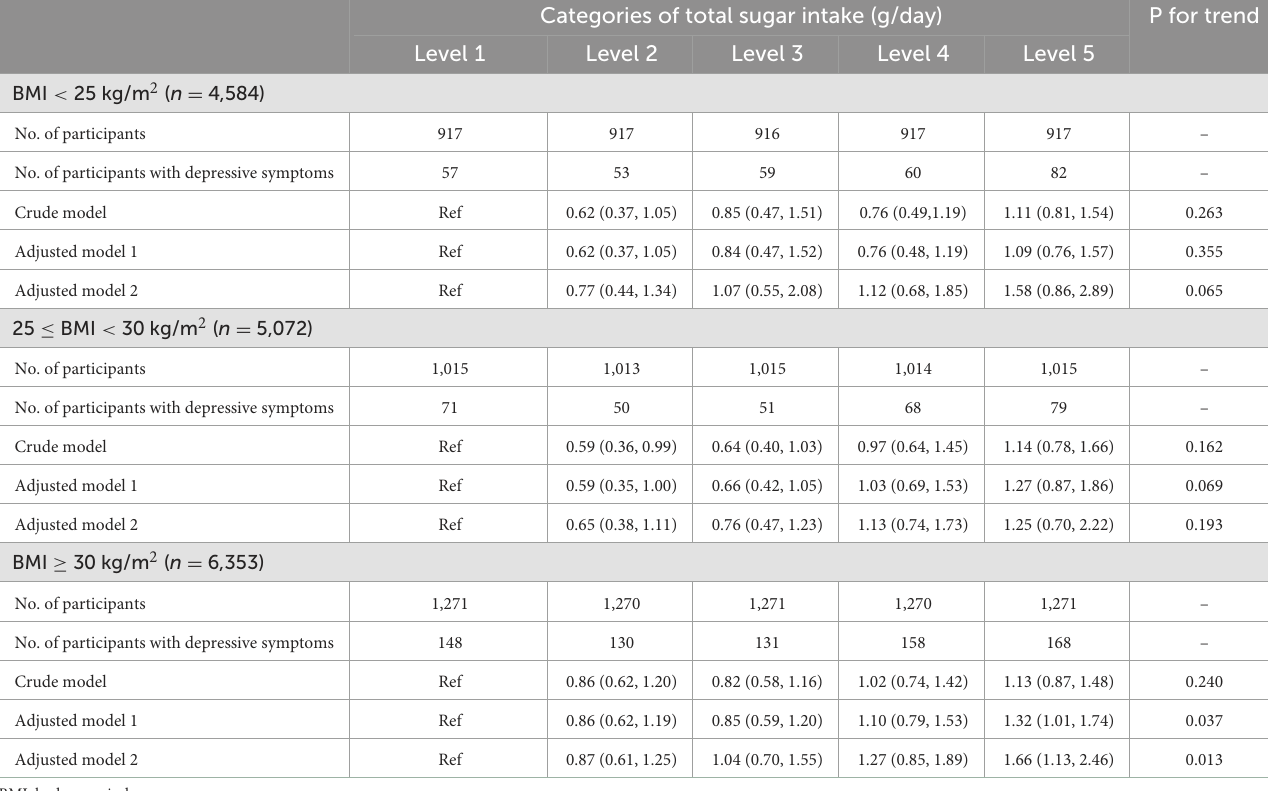
TABLE 3 Associations between total sugar intake and depressive symptoms stratified by